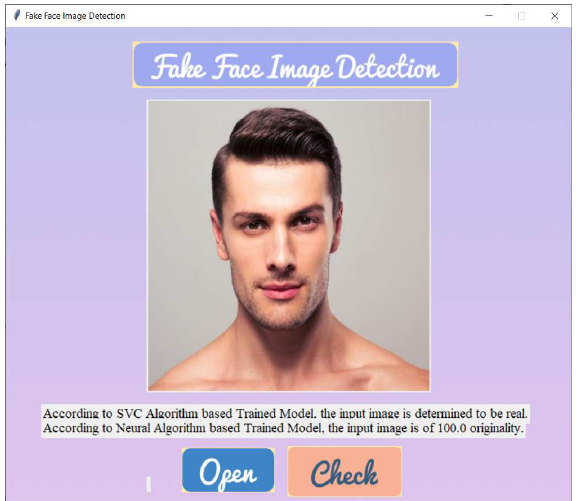
Figure 5. ReLU Graph